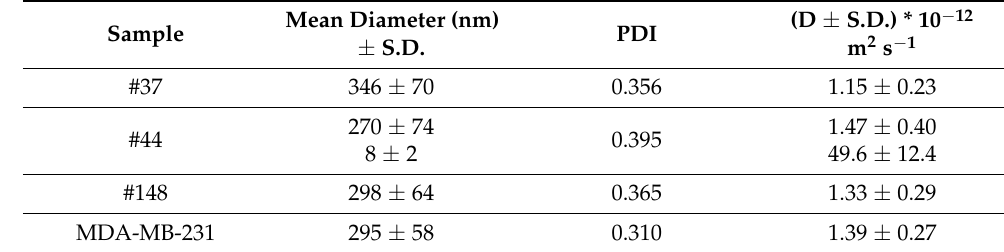
Table 2. Diffusion coefficients (D), mean diameters, and polydispersity indexes (PDI) from DLS measurements for the EVs